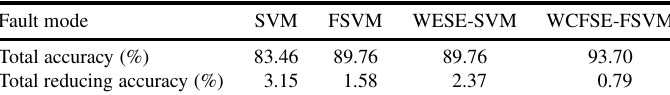
Table 4 Diagnosis results of four methods for anti-noise